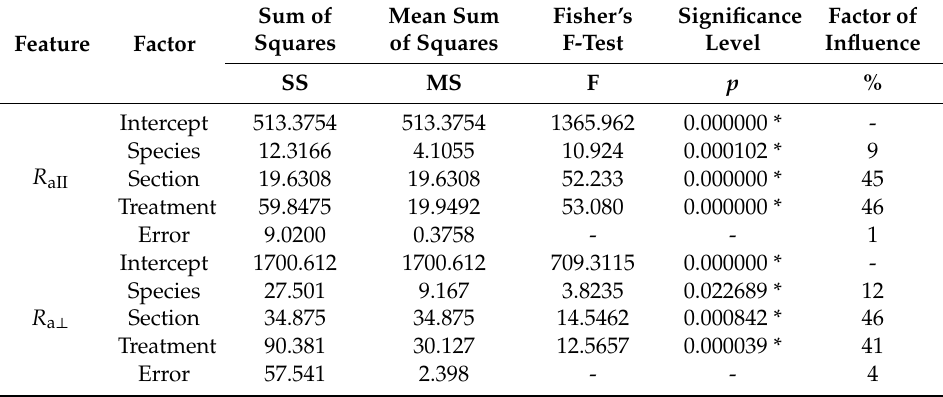
*—significant at the 0.05